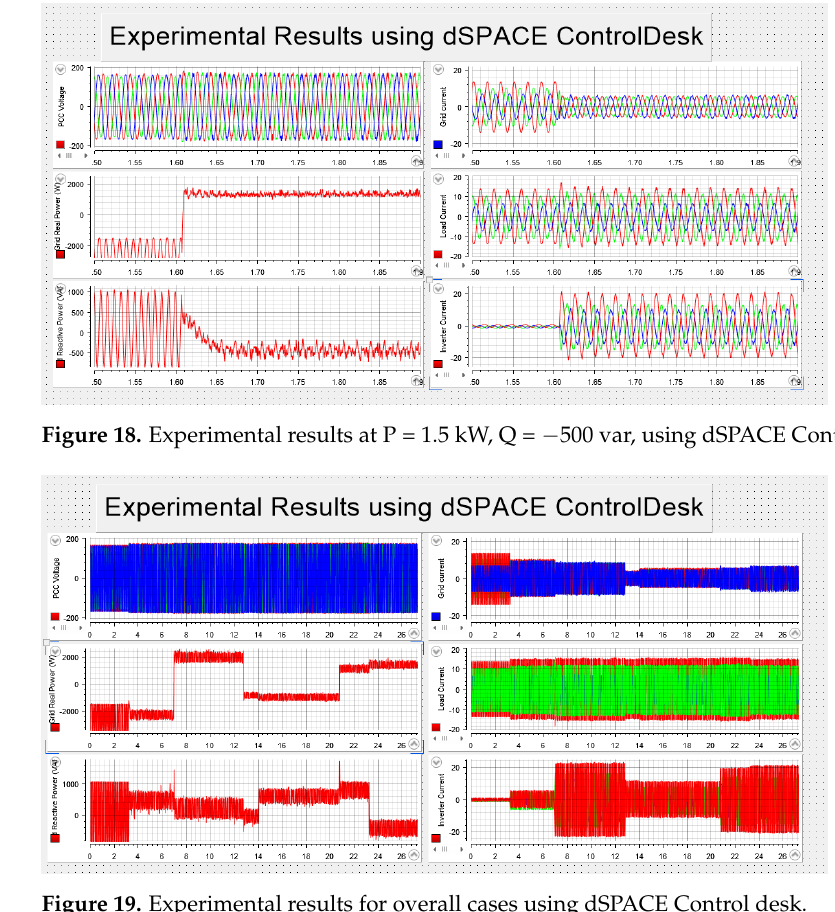
Figure 19. Experimental results for overall cases using dSPACE Control desk.